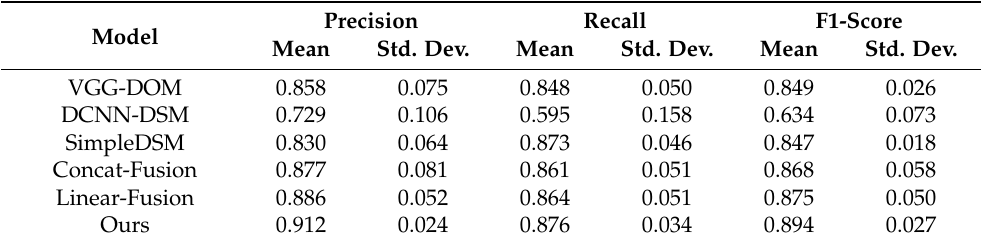
Table 2. Comparison of cross-validation performance. The means and standard deviations of the three metrics are